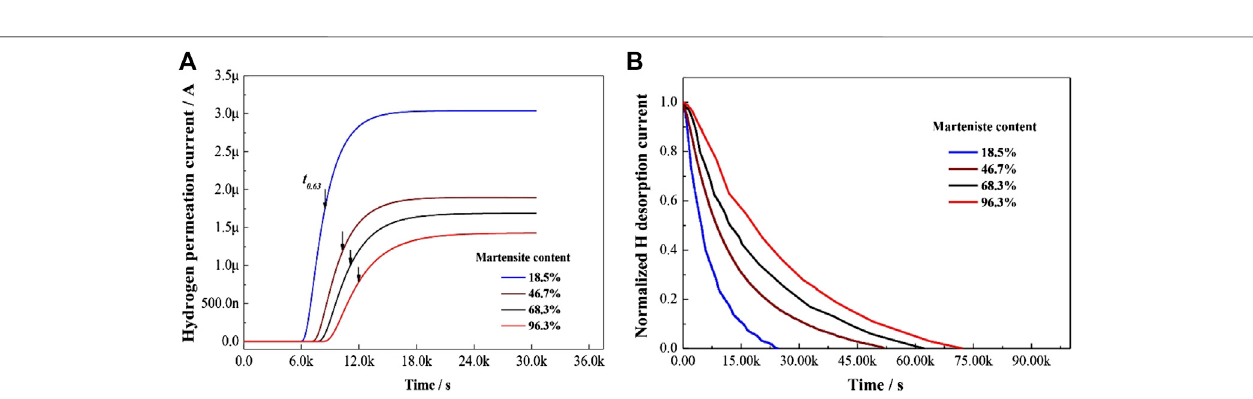
Frontiers in Materials |